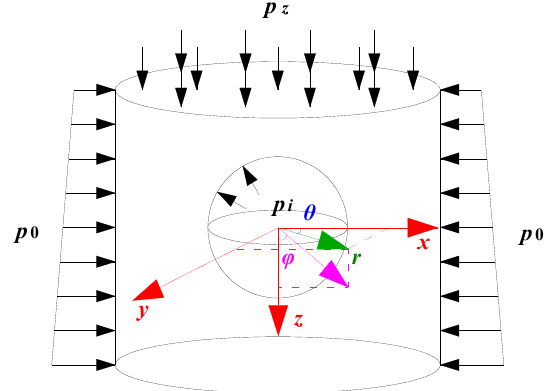
Figure 2. Sketch of limestone strata.